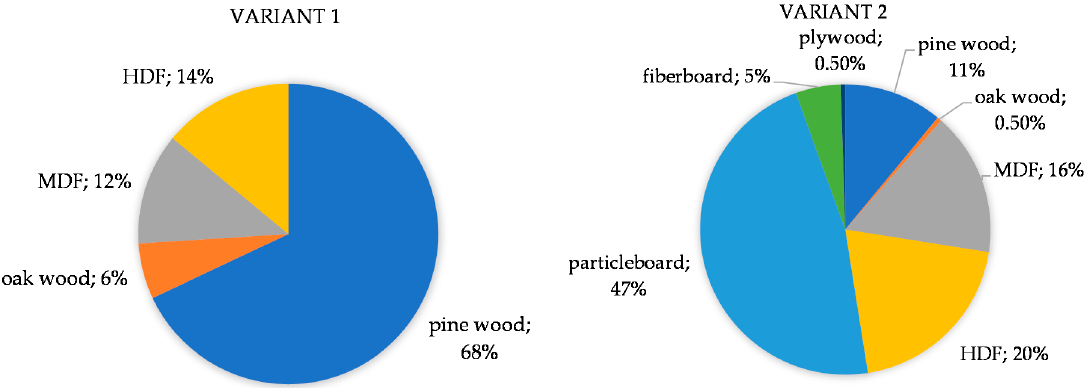
Figure 12. Savings by type of material.